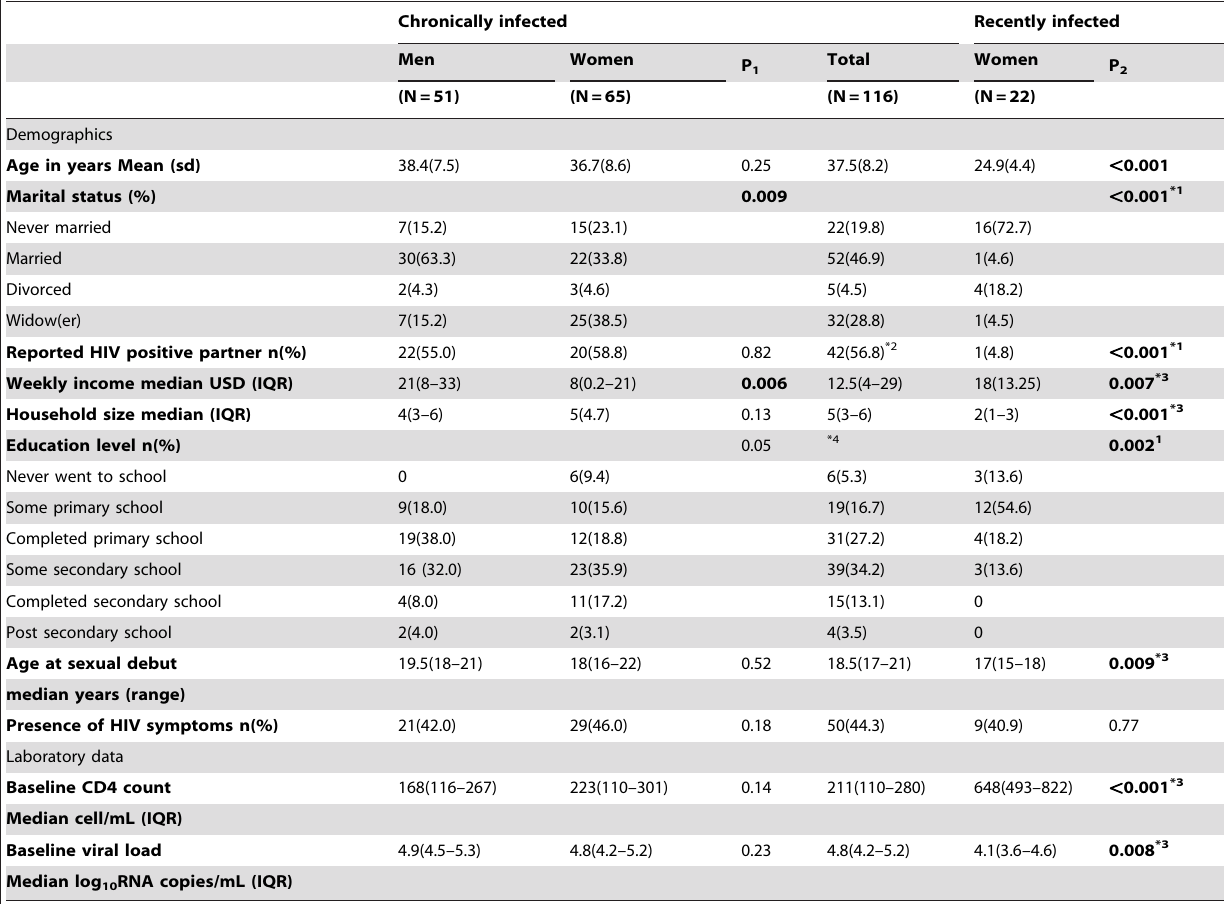
Table 1. Characteristics of the study